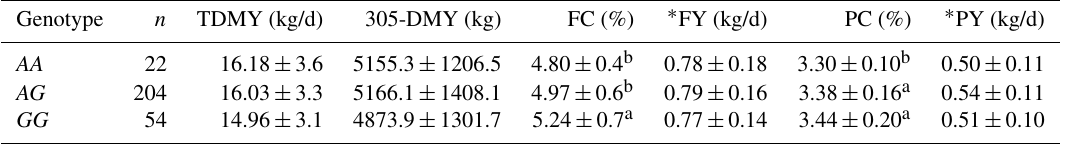
Table 2. Comparison results for the milk-related traits examined in Jersey cattle based on GHR / AluI genotypes (mean ± SD). Genotype